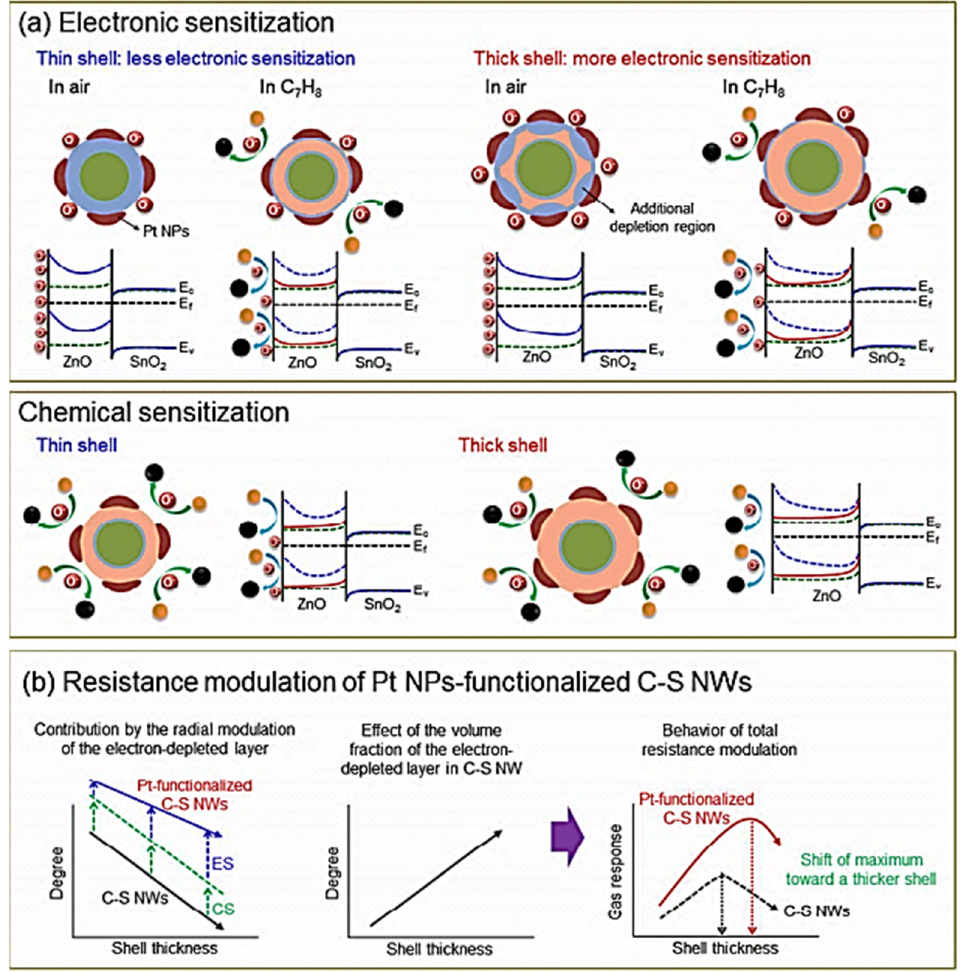
Figure 6. Schematic representation of the C 7 H 8 -sensing mechanism of the Pt-decorated SnO 2 -ZnO C-S NWs; ( a ) ES and CS effects of the Pt NPs and ( b ) shift of the response toward a thicker shell in the presence of Pt. Reproduced from [76] with the permission of the American Chemical Society.